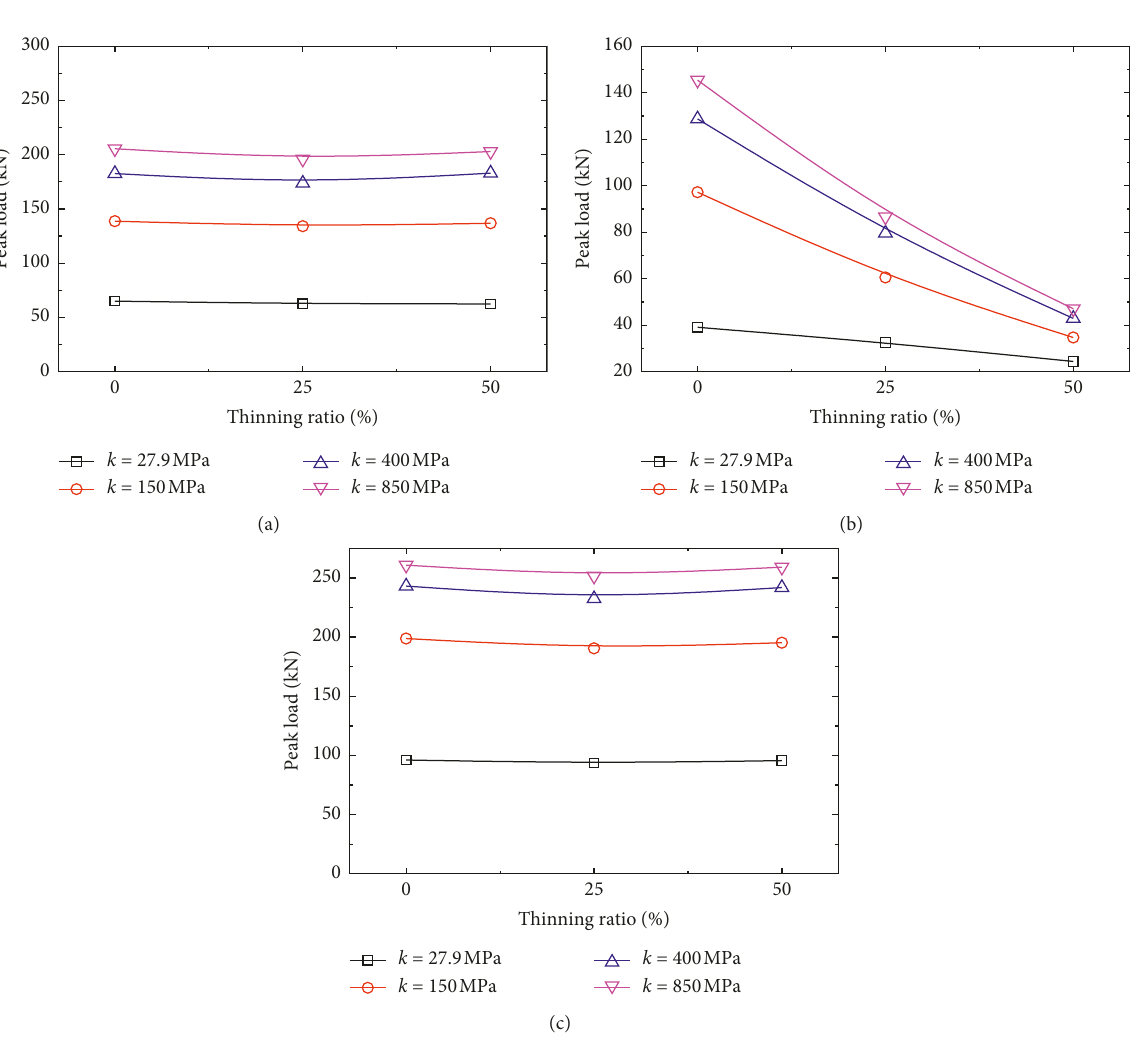
Figure 14: Variation curve of peak load-crown thinning ratio. (a) Vertical load. (b) 45 ° oblique load. (c) Horizontal load.